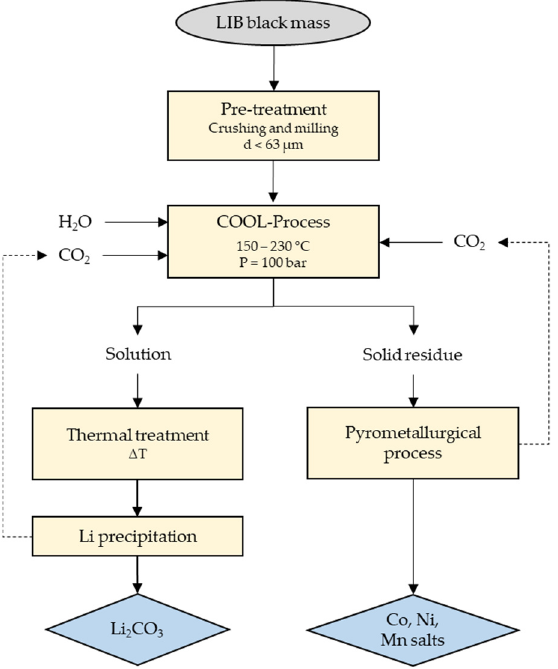
Figure 2. Recycling process scheme of lithium-ion batteries (LIB) black mass.